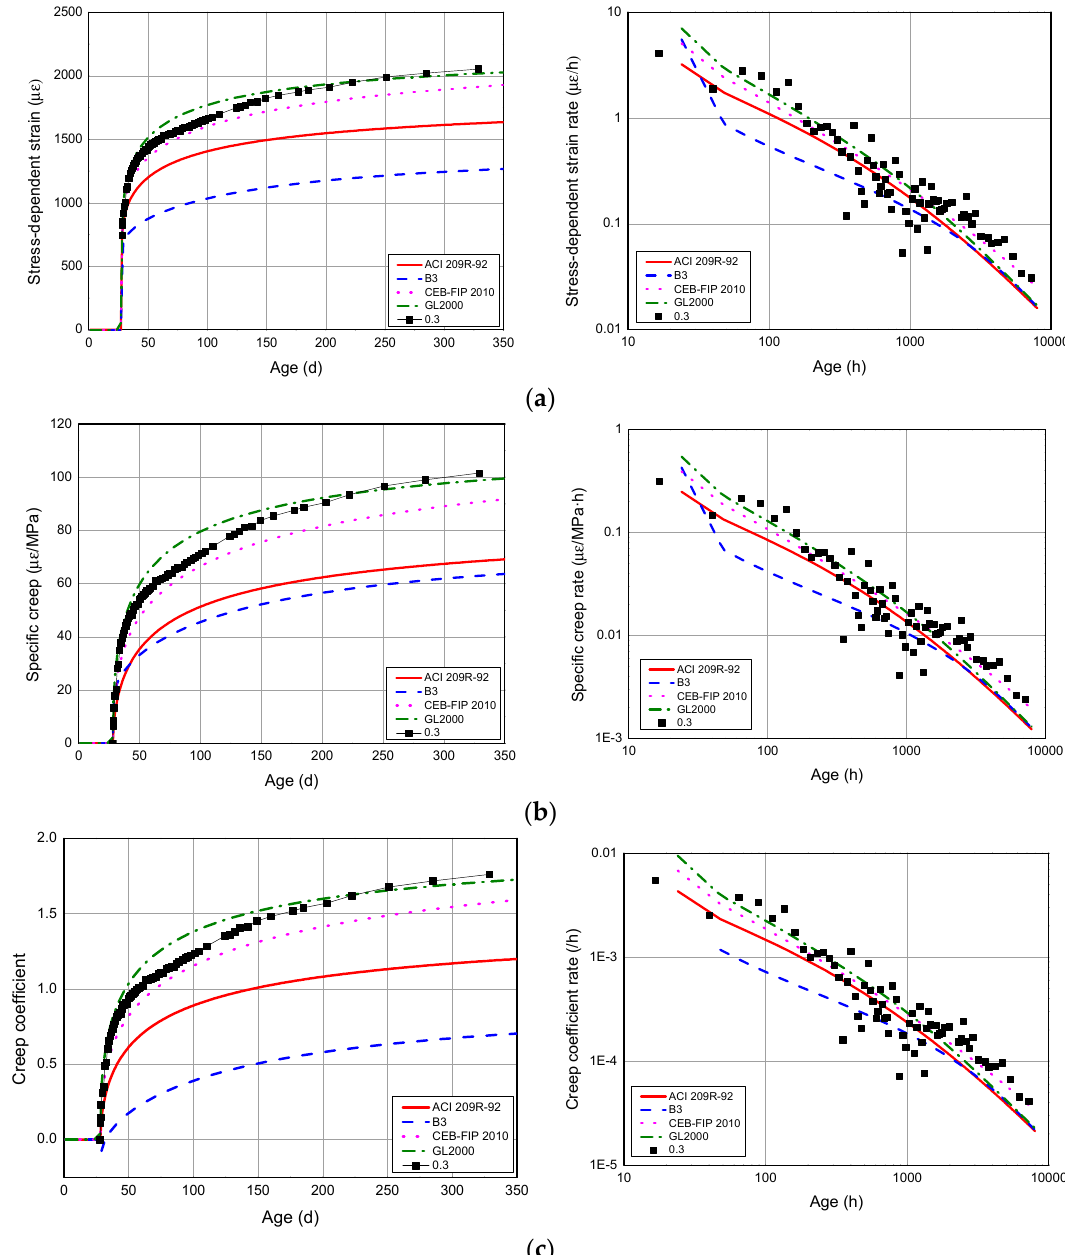
Figure 10. Comparison of creep in AAS concrete using adjustment models. ( a ) stress-dependent strain; ( b ) specific creep; ( c ) creep coefficient.